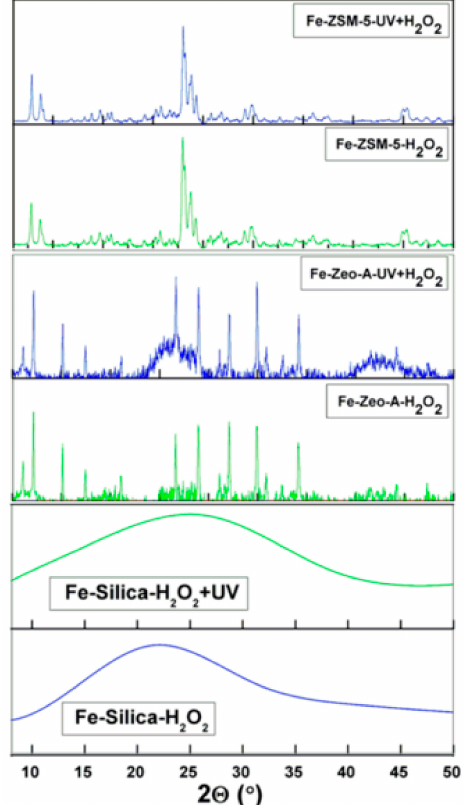
Figure 10. XRD spectra of Fe-ZSM-5, Fe-Zeo-A, and Fe-Silica after phenol degradation with H 2 O 2 and H 2 O 2 +